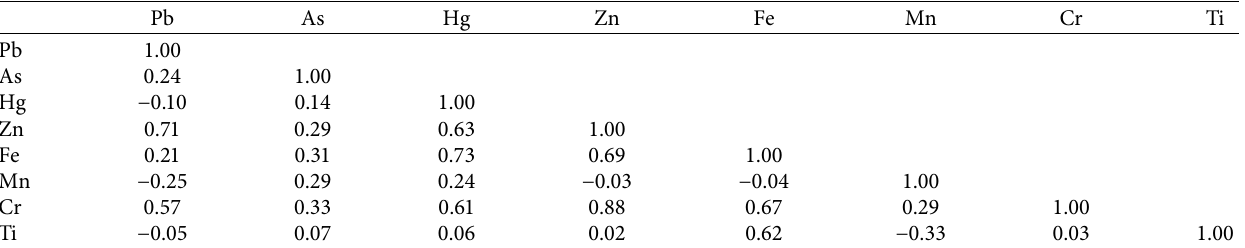
Table 2: Pearson’s correlation for trace elements.